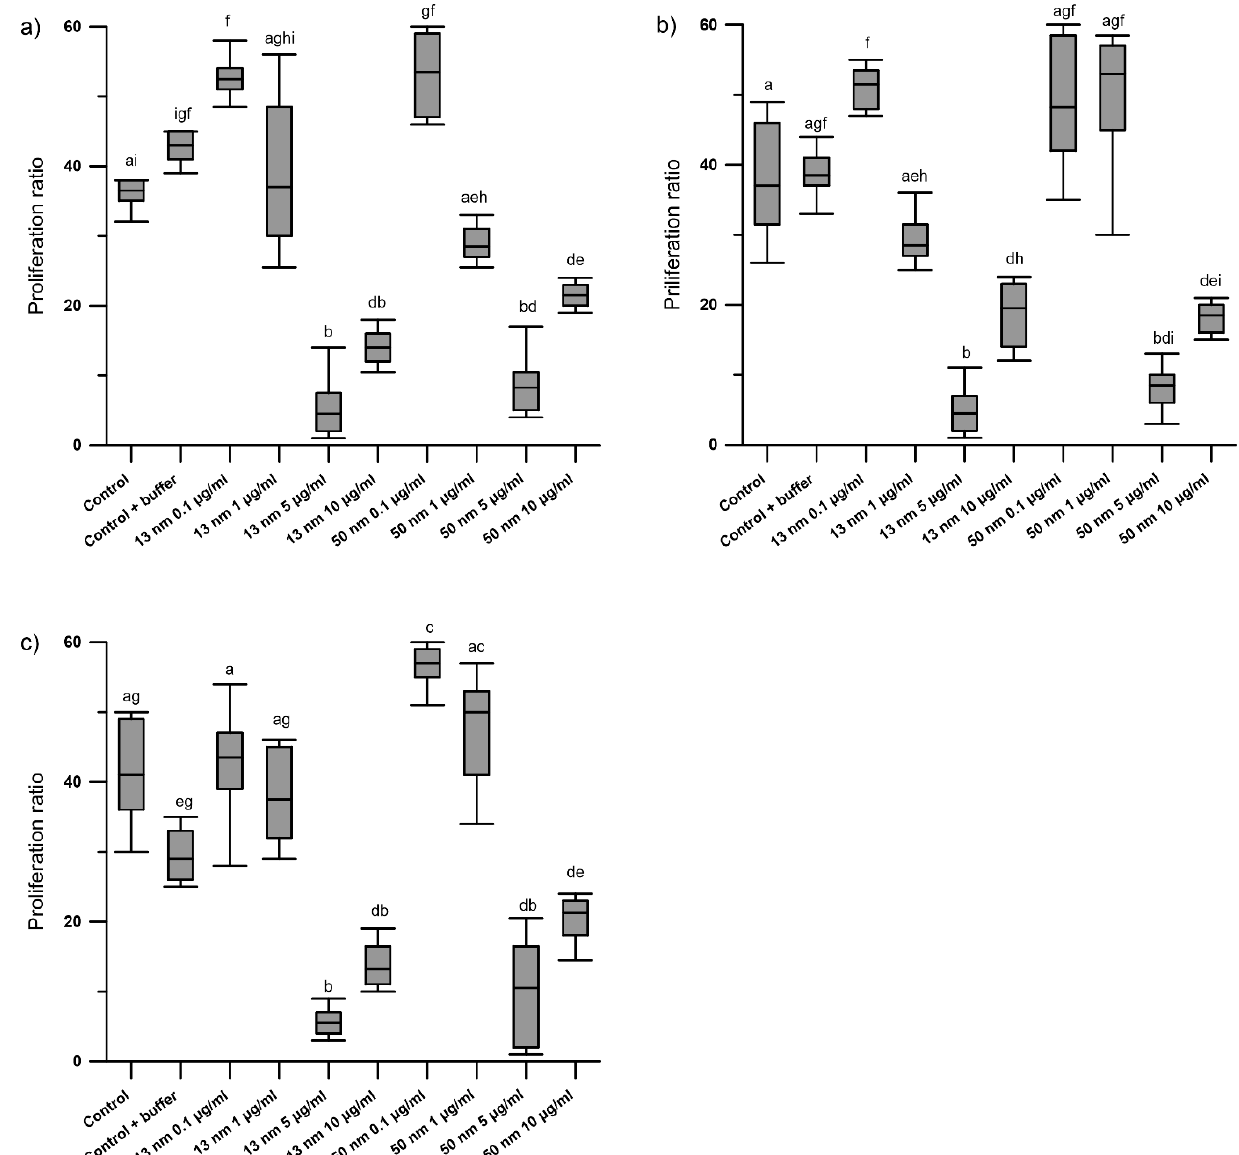
Figure 1. In vitro effect of increased concentrations of 13 nm and 50 nm AgNPs on the proliferation ratio of chicken granulosa cells isolated from F3 ( a ), F2 ( b ), and F1 ( c ) preovulatory follicles after 24 hours of incubation. Values marked with different letters differ significantly ( p < 0.05).